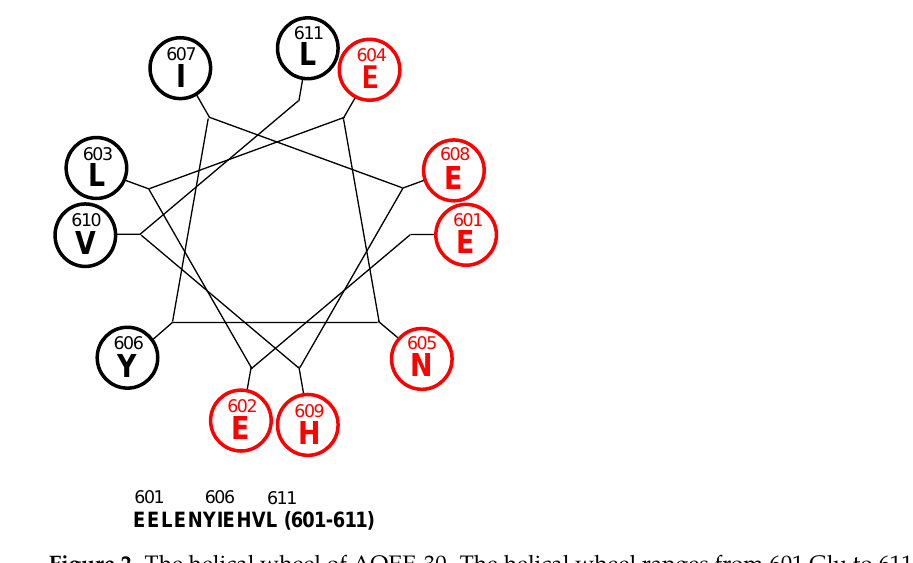
Figure 2. The helical wheel of AQEE-30. The helical wheel ranges from 601 Glu to 611 Leu, which shows amphiphilicity. The sequence is below the helical wheel. Hydrophilic residues are marked by red color and hydrophobic residues are marked by black color.